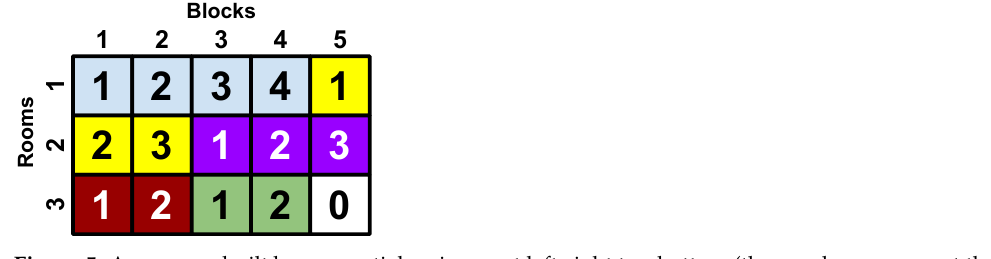
Figure 5. A program built by sequential assignment left-right top-bottom (the numbers represent the order of insertion in the